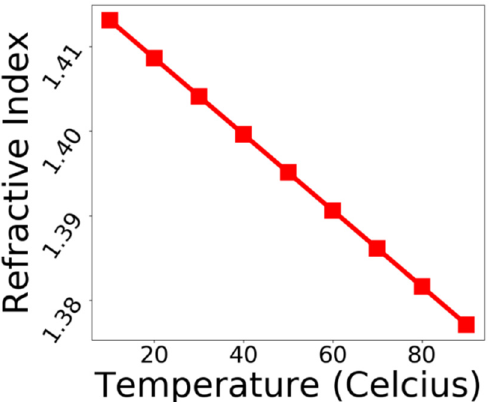
Figure 3. Refractive index variation of PDMS as a function of ambient temperature.